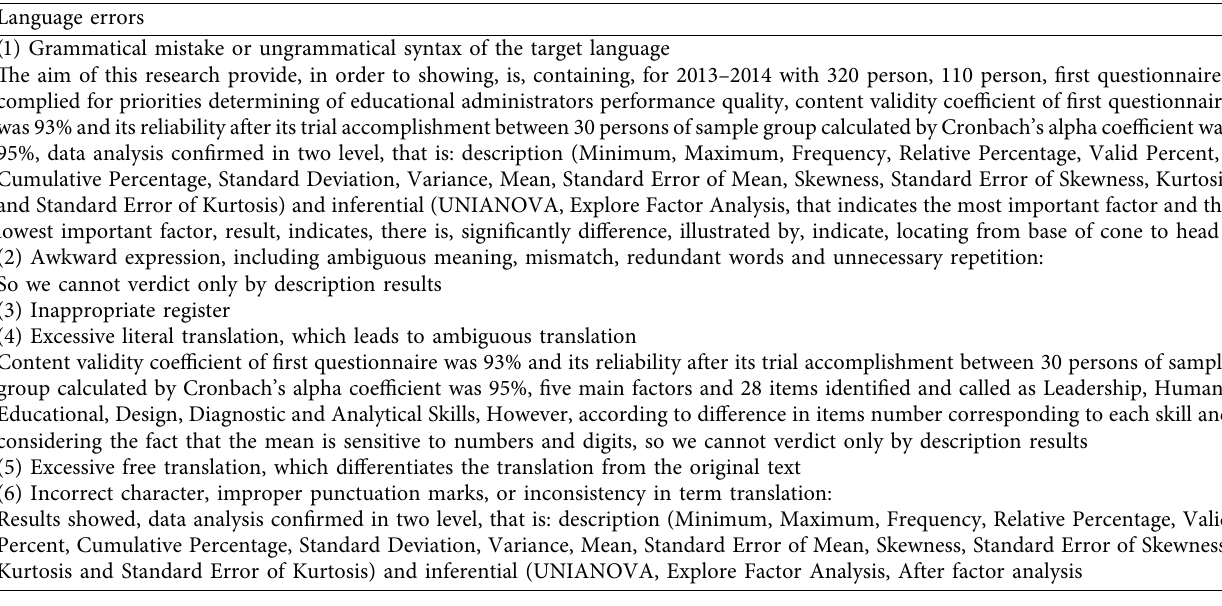
Table 6: Language errors related to Sample